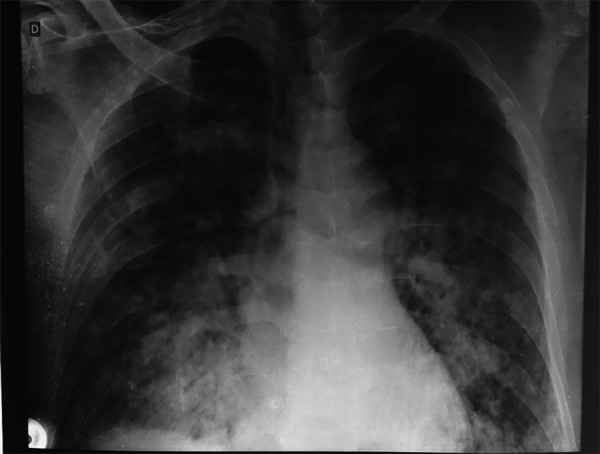
Initial chest X-ray.